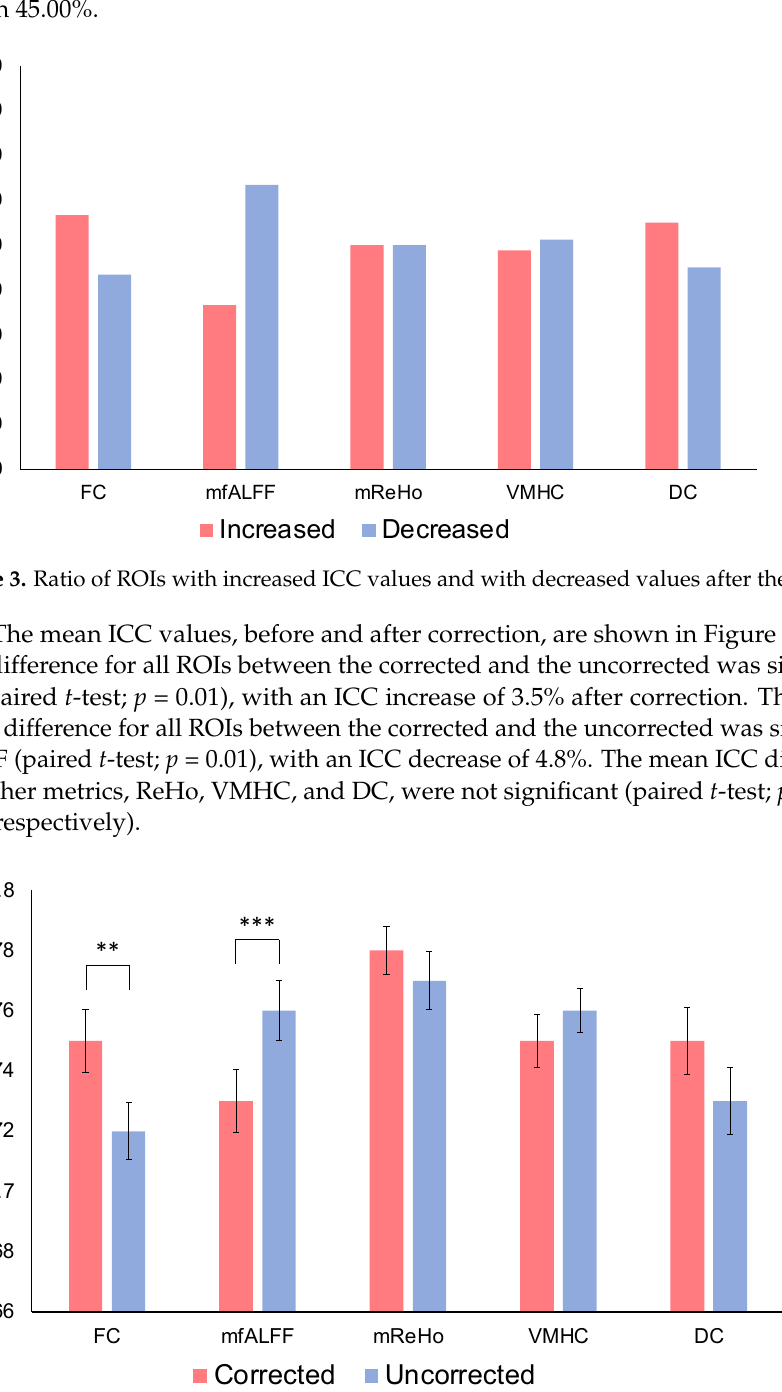
Figure 4. Comparison of mean ICC values over all ROIs, before and after correction, for functional connectivity (FC), fractional amplitude of low ‐ frequency fluctuation (fALFF), regional homogeneity (ReHo), voxel ‐ mirrored homotopic connectivity (VMHC), and degree centrality (DC). ** p < 0.01, *** p < 0.001 (paired t ‐ test).